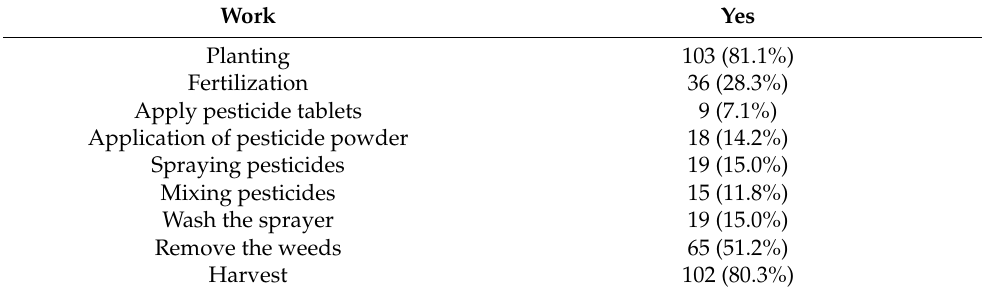
Table 2. Kinds of work for farmers ( n = 127).